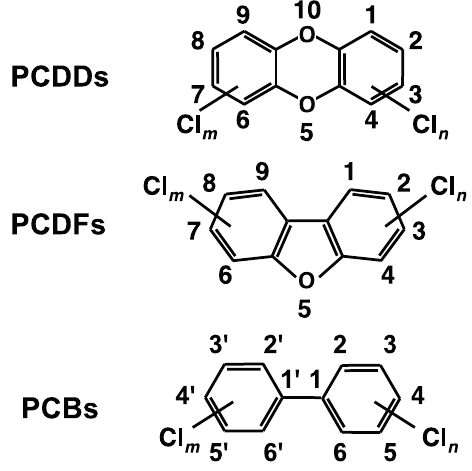
Figure 1. Structures of polychlorinated dibenzo- p -dioxins (PCDDs),